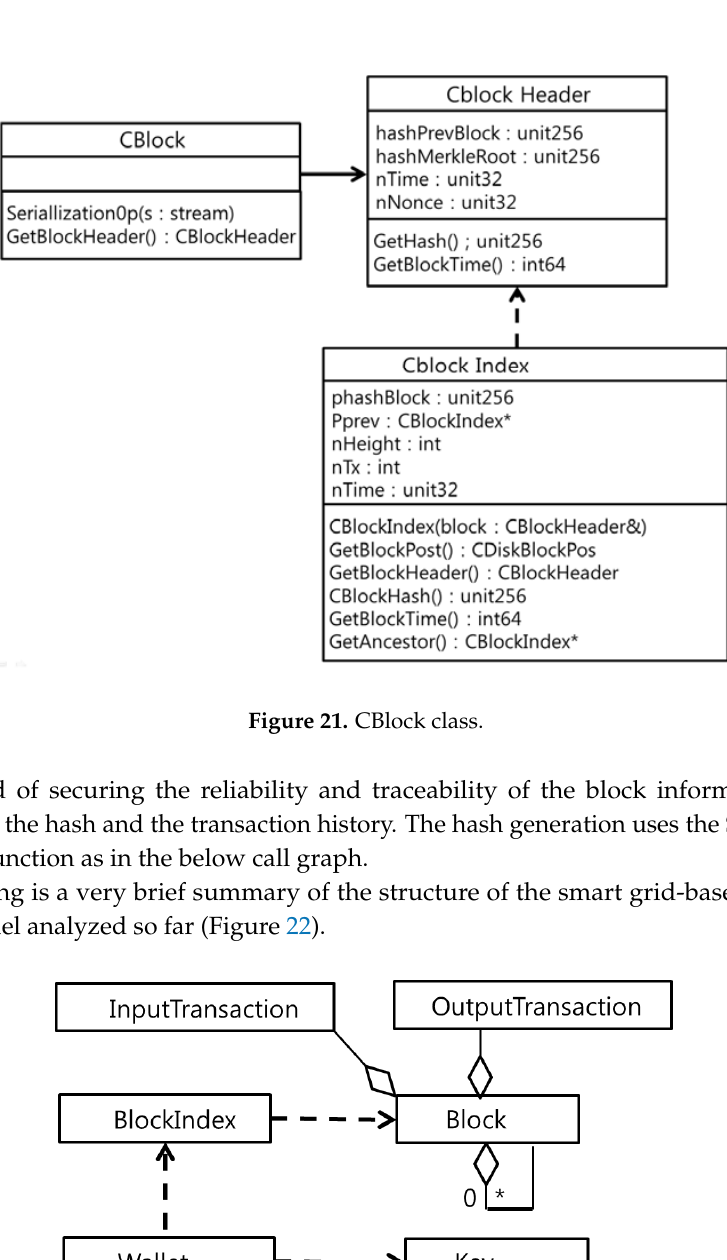
Figure 20. CBlockIndex.